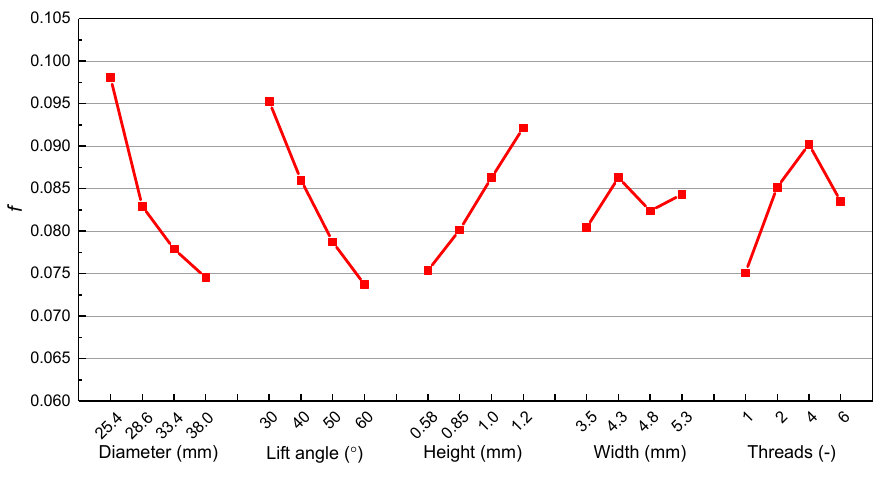
( a ) Effect of rib structures parameters on friction coefficient Figure 13.